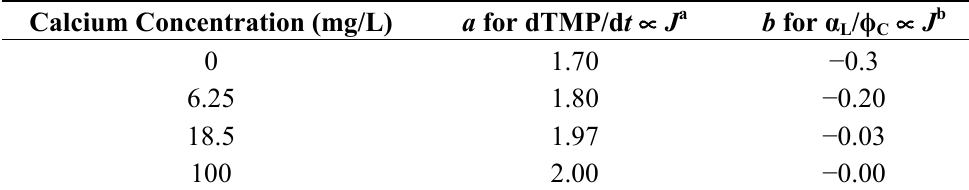
Table 1. Flux effect power index for dTMP/d t and α